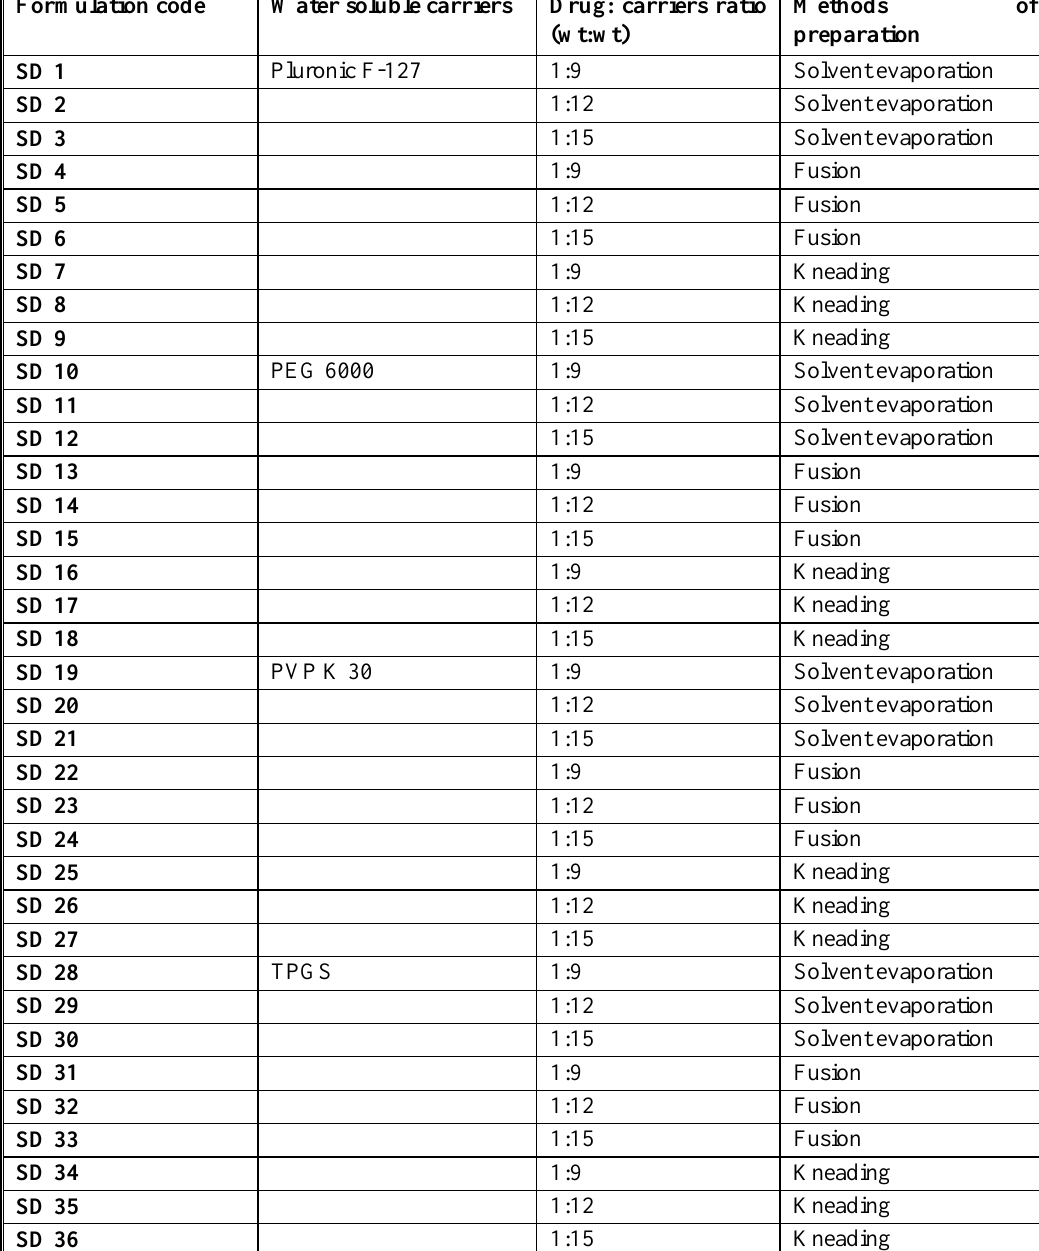
Table 1. Composition of REM and carriers using solid dispersion method. Formulation